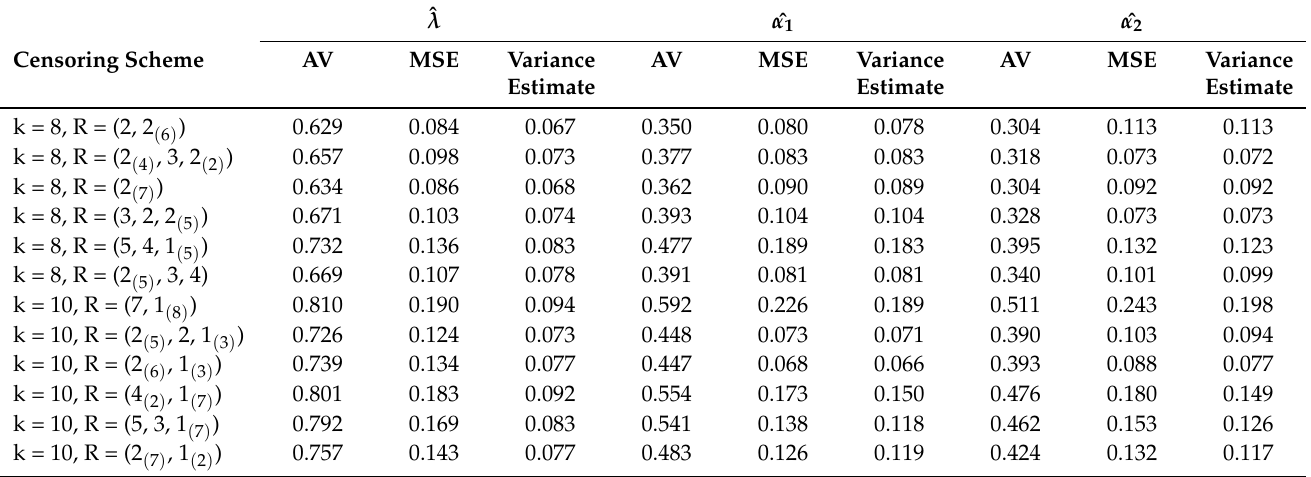
Table 2. MSEs and AVs of the MLEs of the model parameters with λ = 0.5, α 1 = 0.4, and α 2 = 0.3 based on different CSs.